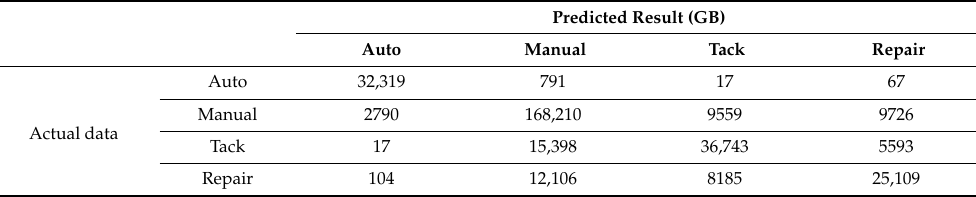
Table 6. Confusion matrix of the GB classification